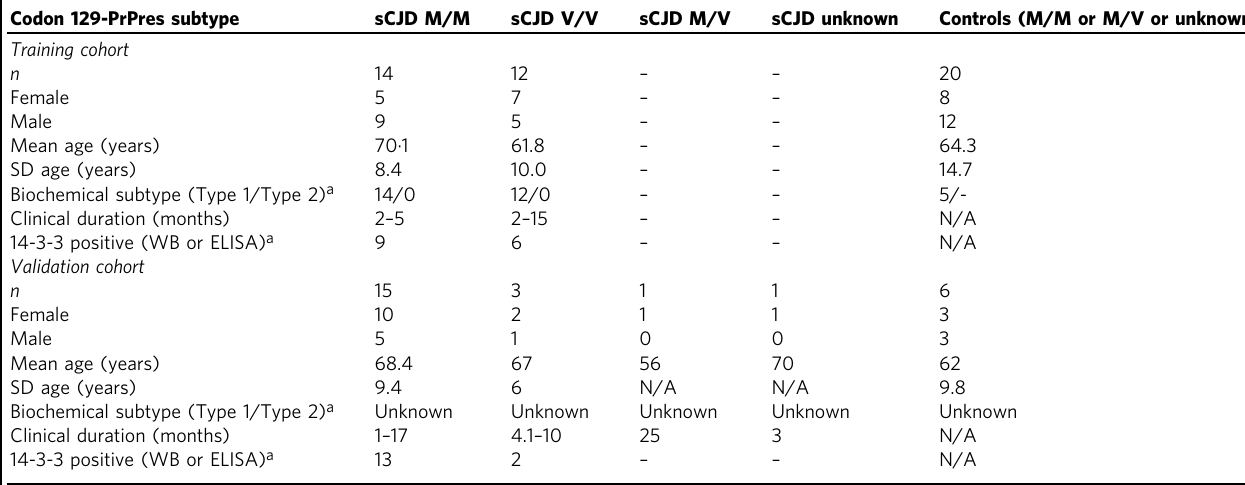
Table 1 Demographics of human clinical patients by study group. Codon 129-PrPres